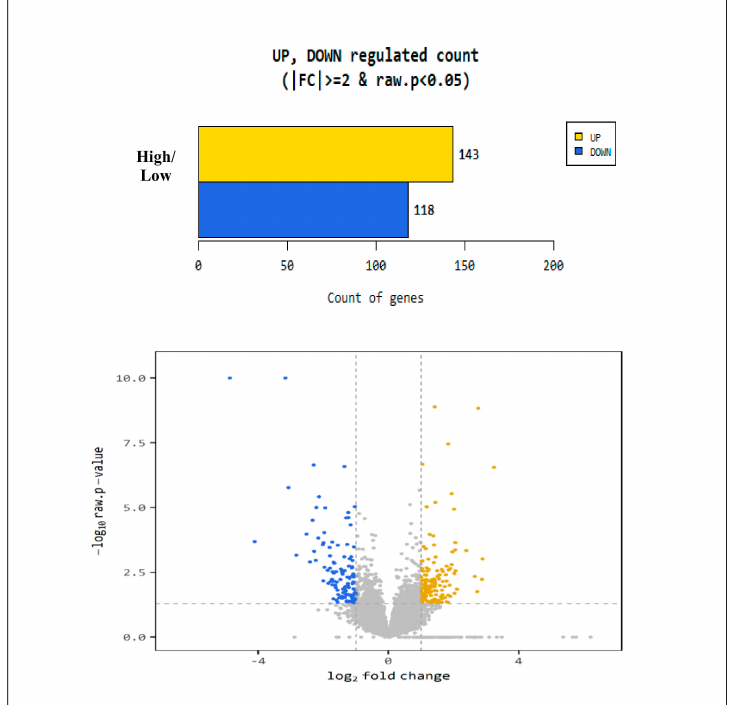
Figure 3. Number of up- and down-regulated genes after comparison of normalized values using the DESeq2